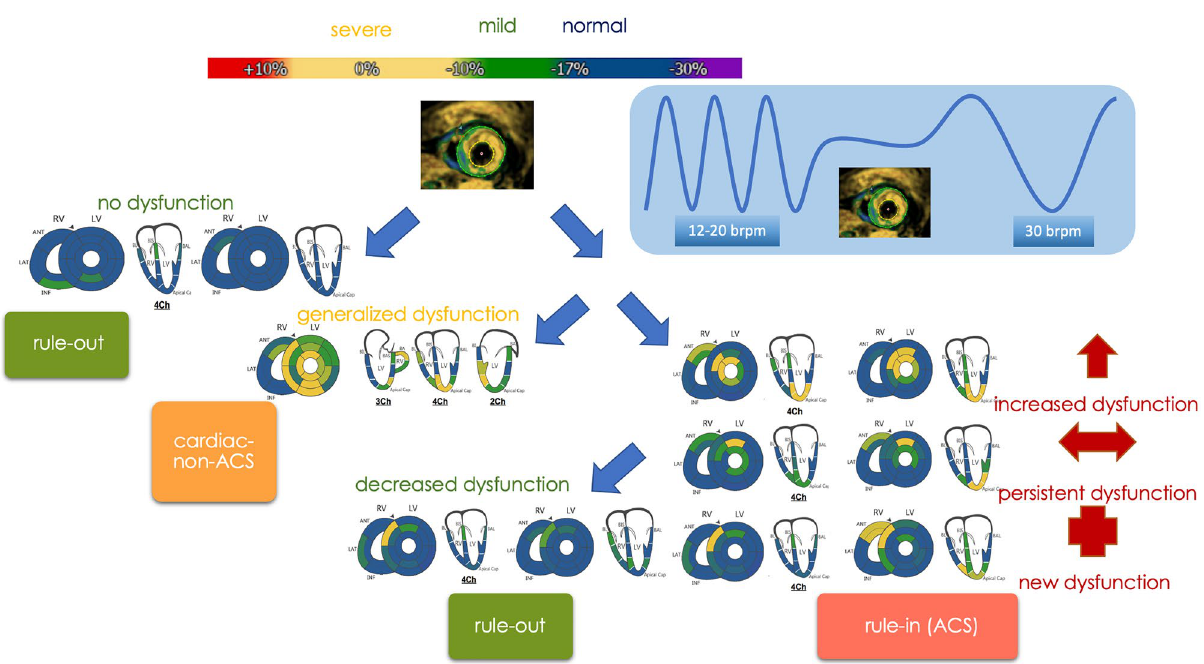
Figure 1. Analysis workflow: triage according to change in myocardial deformation before (left) and after hyperventilation: 1 min at 30 brpm followed by a short breath-hold for image acquisition (right). Rule- out = normal contractility at rest and after hyperventilation or improved contractility after hyperventilation; cardiac, non-ACS = generally impaired myocardial deformation; rule-in = increased/persistent or new onset of dysfunctional segments after